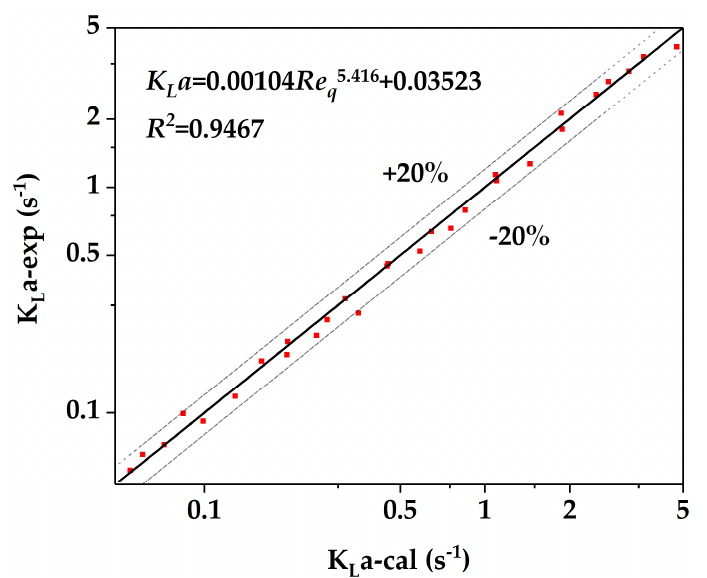
Figure 12. Comparison of the experimental value ( point ) and calculated fitting curve of volumetric mass transfer coefficient over Reynold number.